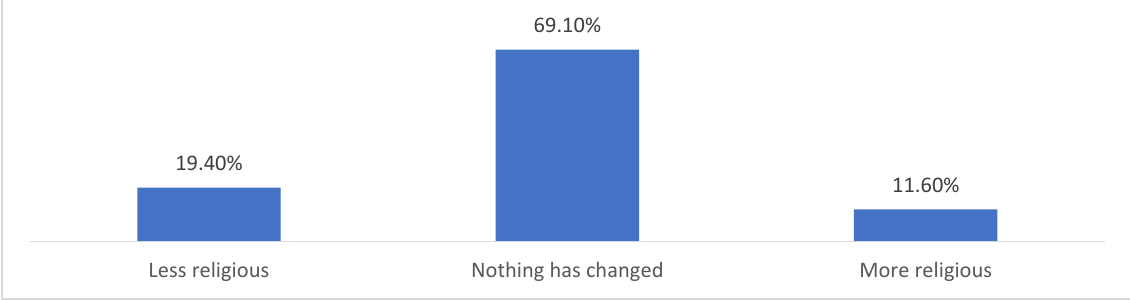
Figure 2. Respondents’ declarations about the impact of the pandemic on religiosity.